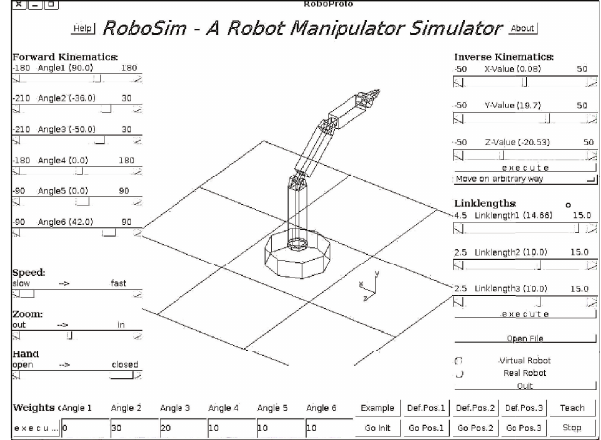
Figure 5: The RoboSim Robotic Arm Simulator. The simulator allows for both forward and inverse kinematics, learning of a sequence of movements, varying degrees of freedom and link lengths, and speed control.